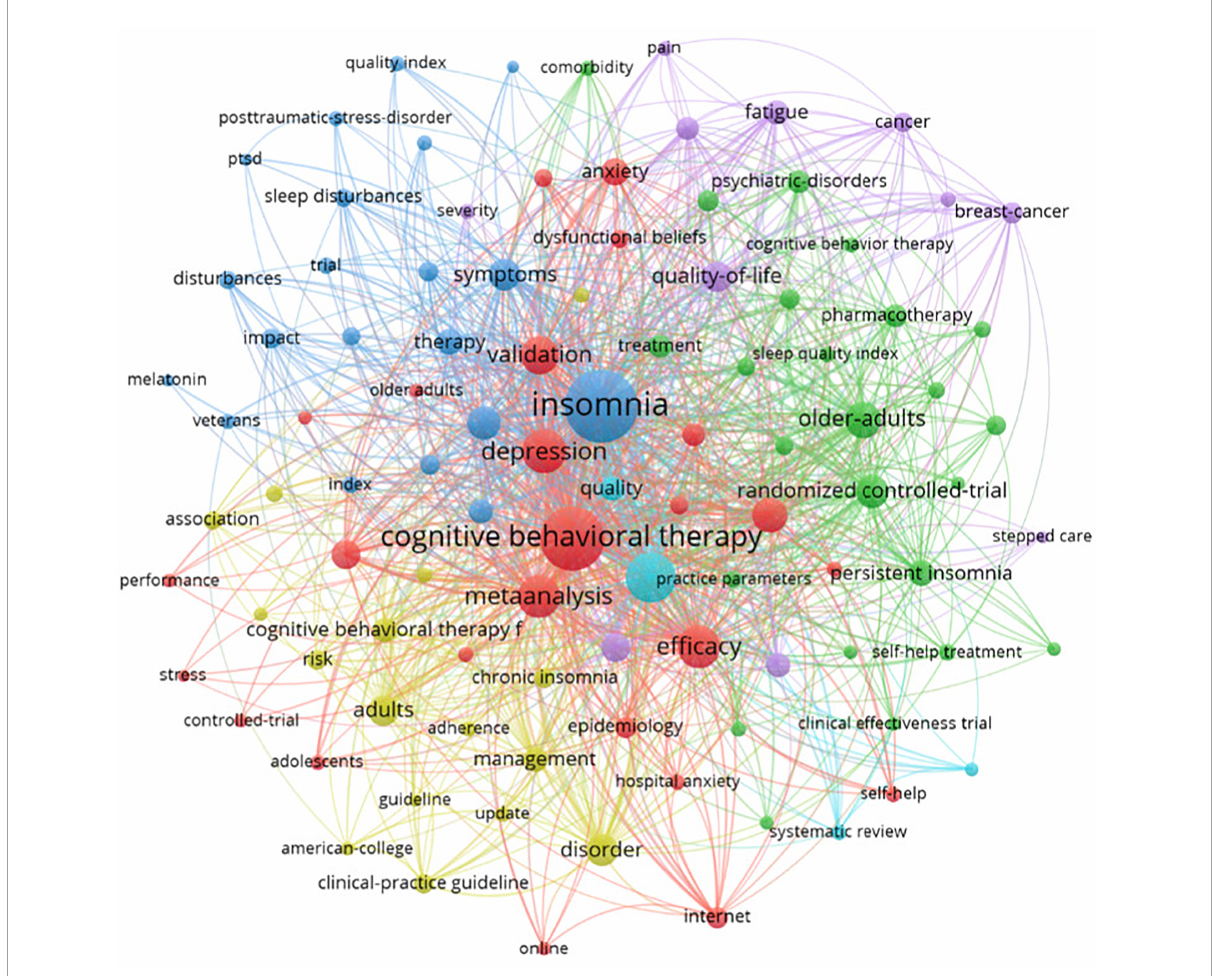
FIGURE3 Network visualization map of co-occurrence on top 100 keywords. Each node is represented by a circle with labels for different words. Larger circles represent more frequently used words. The thickness and length of the lines linked between nodes represent the strength of the association between the corresponding